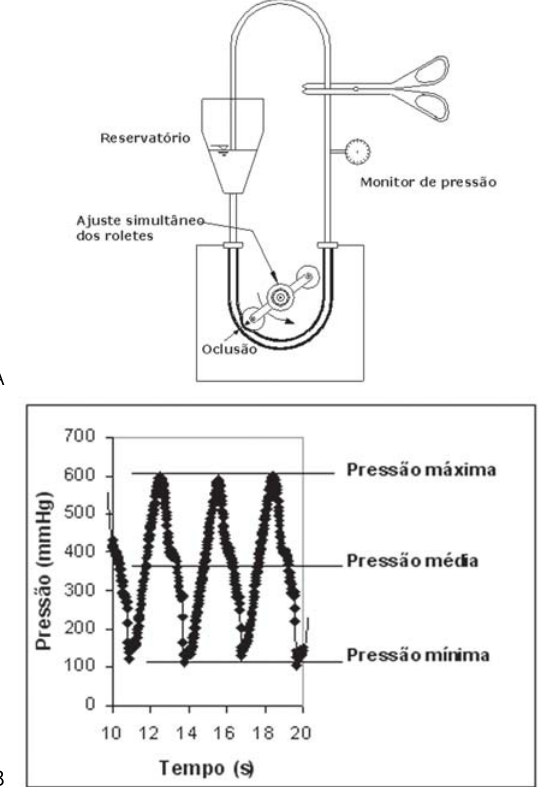
Fig. 2 – A: Desenho esquemático para medidas de calibração dinâmica. B: Indicação dos valores de pressão máxima, mínima e média durante o processo de calibração